Question: Which kind of chart has been used to present this data?
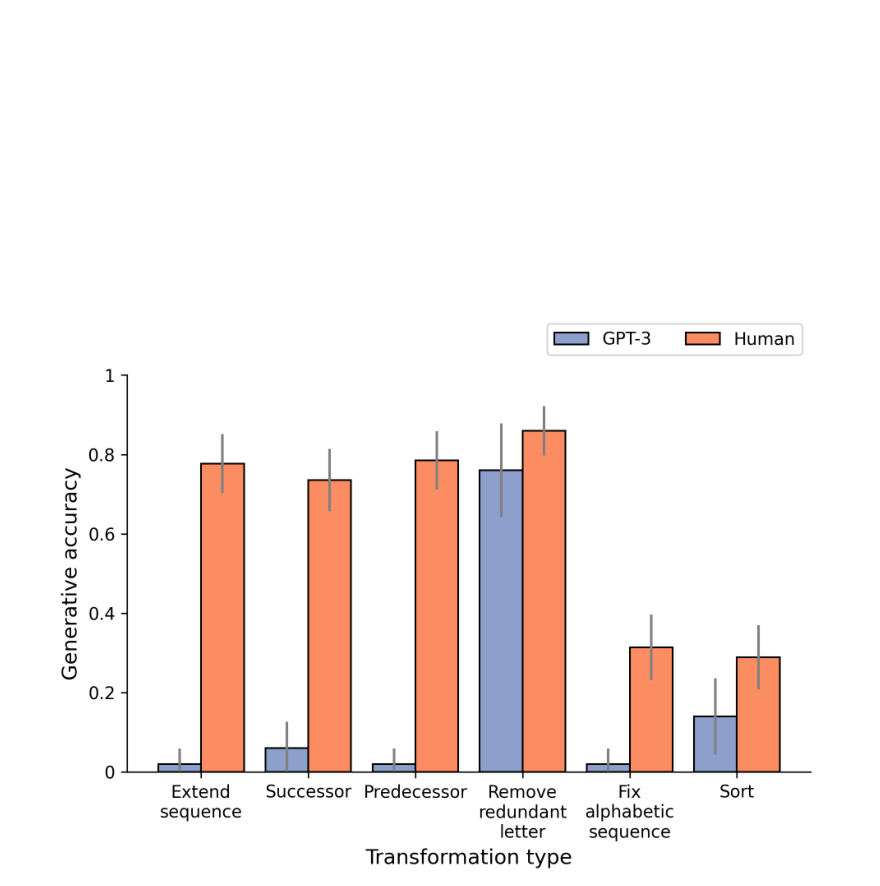
Answer: bar